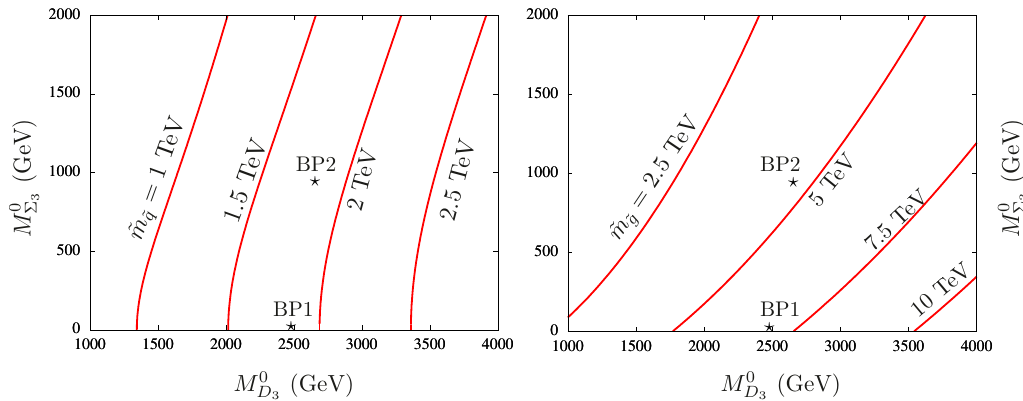
~ q ( (cid:22) IR ) as a function of the UV inputs: the . Right: mass of the lightest eigenvalue of the (cid:6) 3